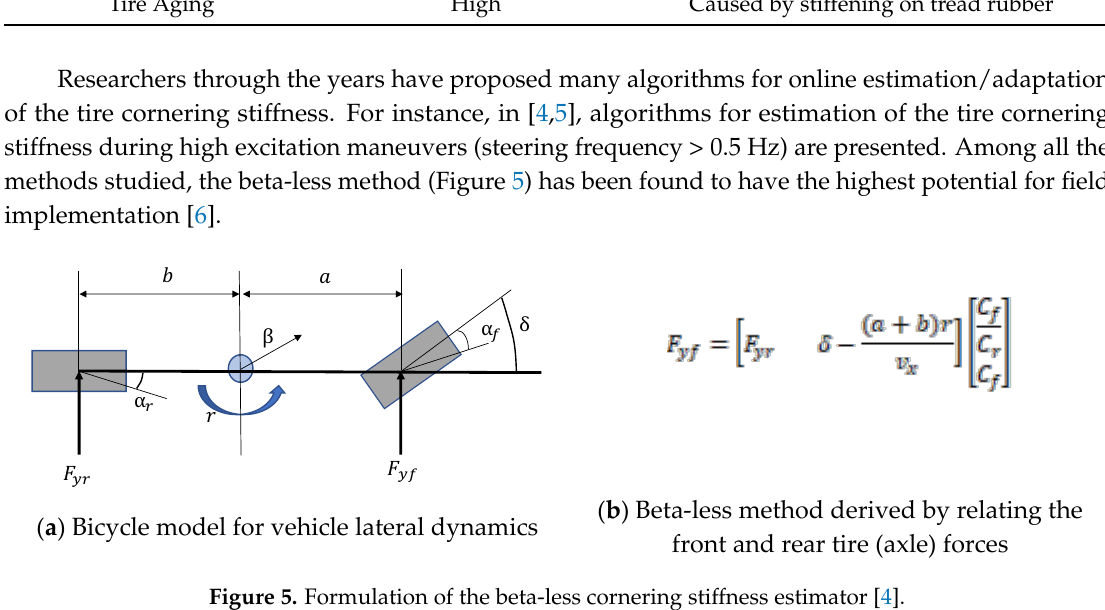
Table 2. Factors affecting the tire cornering stiffness .